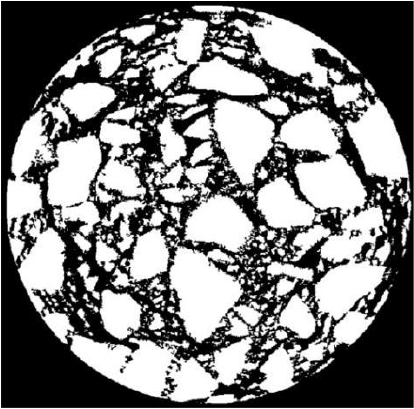
Figure 10. Separation effect of aggregates in CT image.